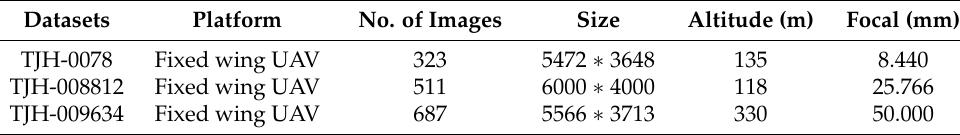
Table 1. Details of the three datasets.